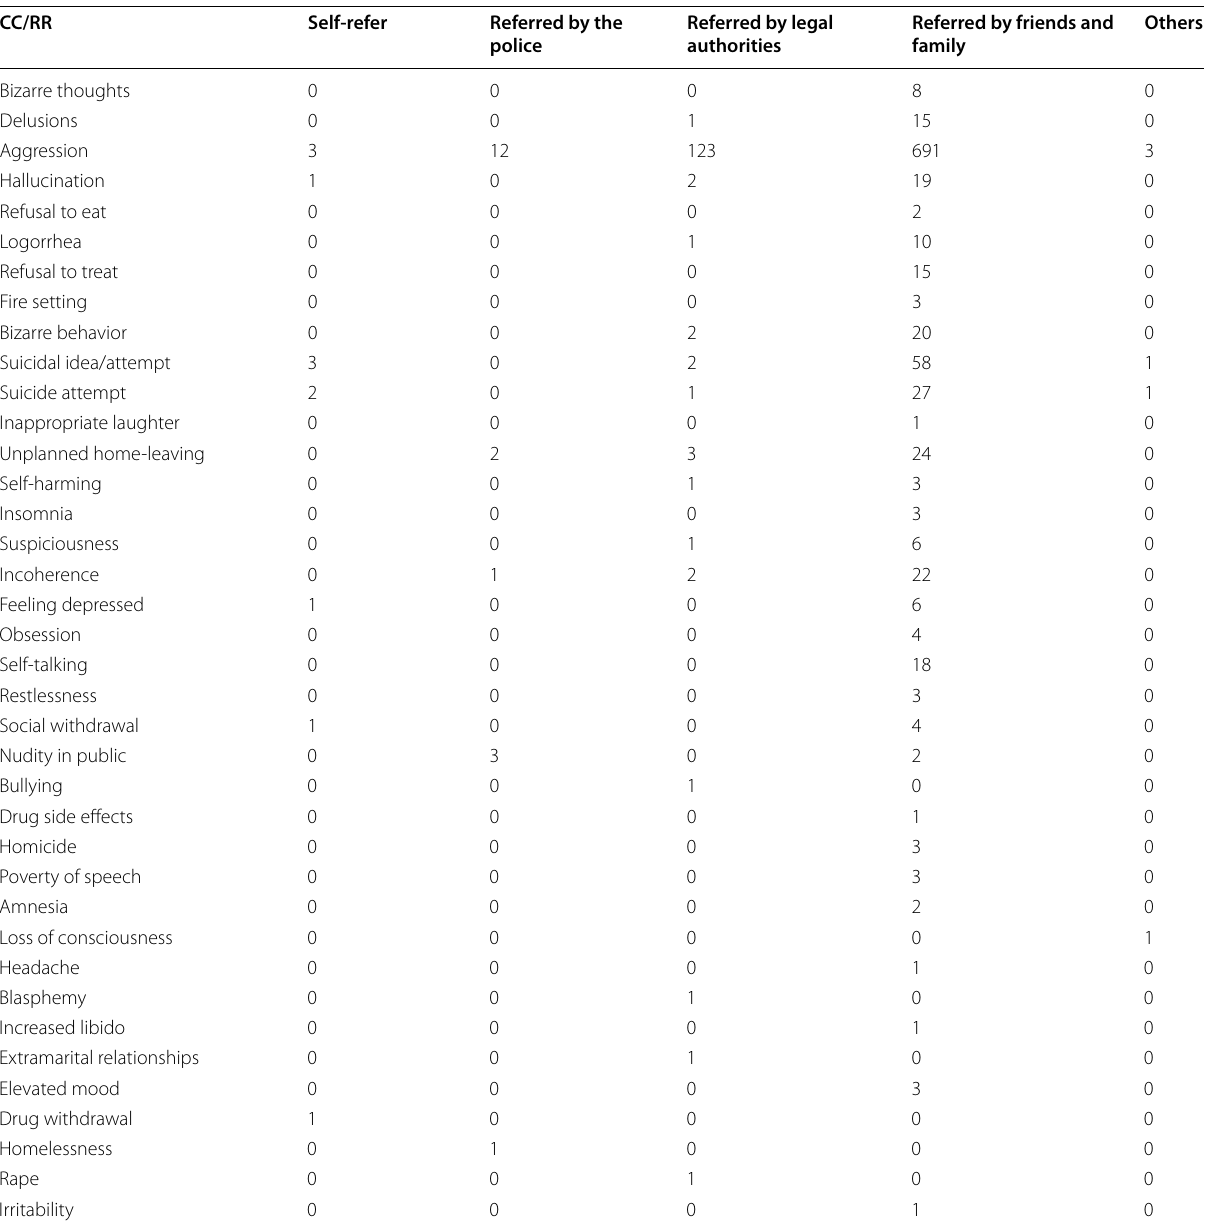
Table 2 Frequency of chief complaints/reasons of referral of the patients by different sources of referral